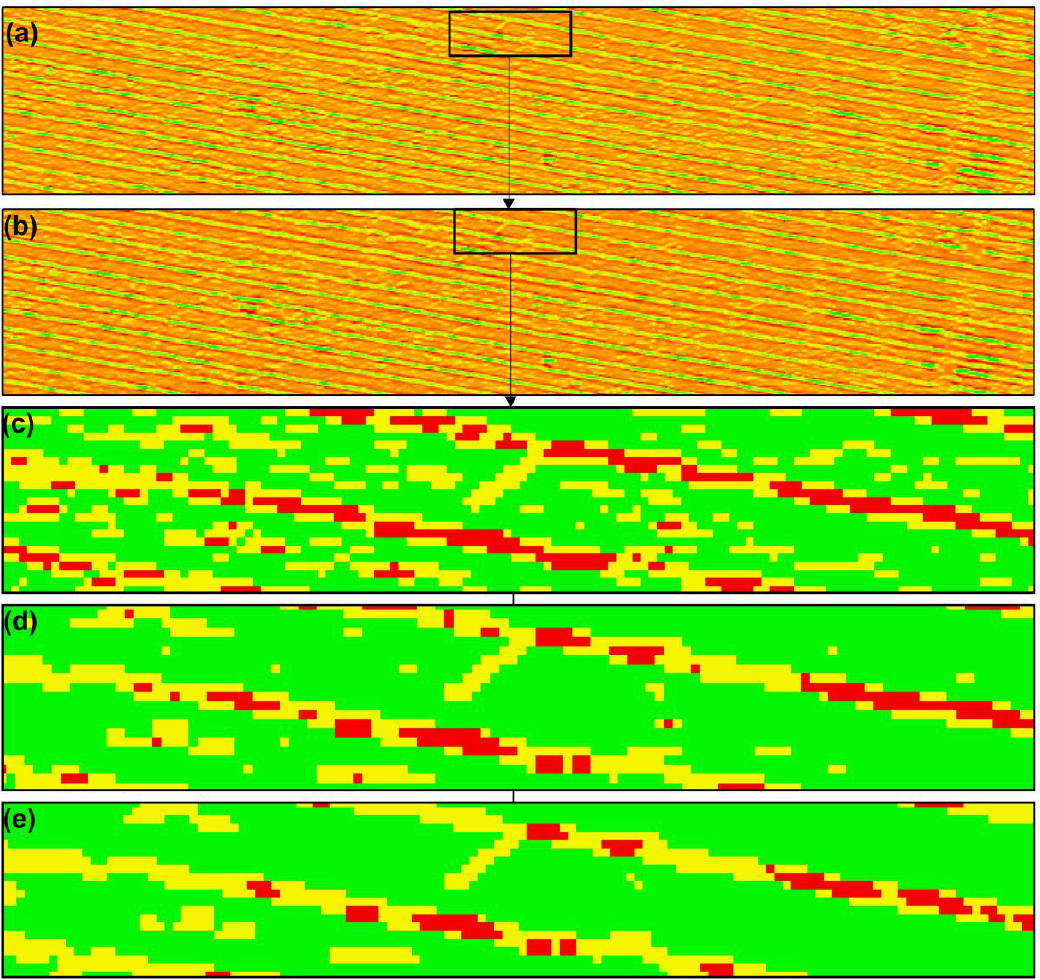
Figure 11. Image transformation, clustering, and smoothing process: ( a ) PCA component-1 generated by using the LDF images and modal filter images. The lines features are categorically distinct from background soil; ( b ) PCA component-1 smoothing by a median convolutional filter; ( c ) K-means clustering of PCA component-1 before applying the median convolutional filter, where background noise level is high; ( d ) K-means clustering of PCA component after median convolutional filter, where background noise is significantly reduced; ( e ) conservative smoothing filter applied on K-means clustering (d) to further reduce the background noise where line features are categorically distinct from background soil.